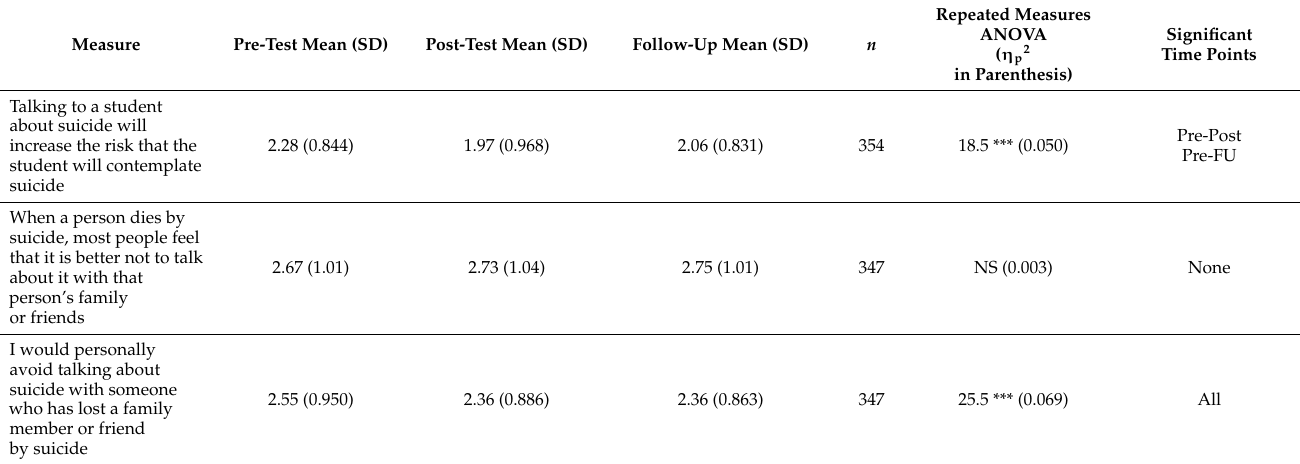
Table 4. Please indicate if you disagree/agree with the following